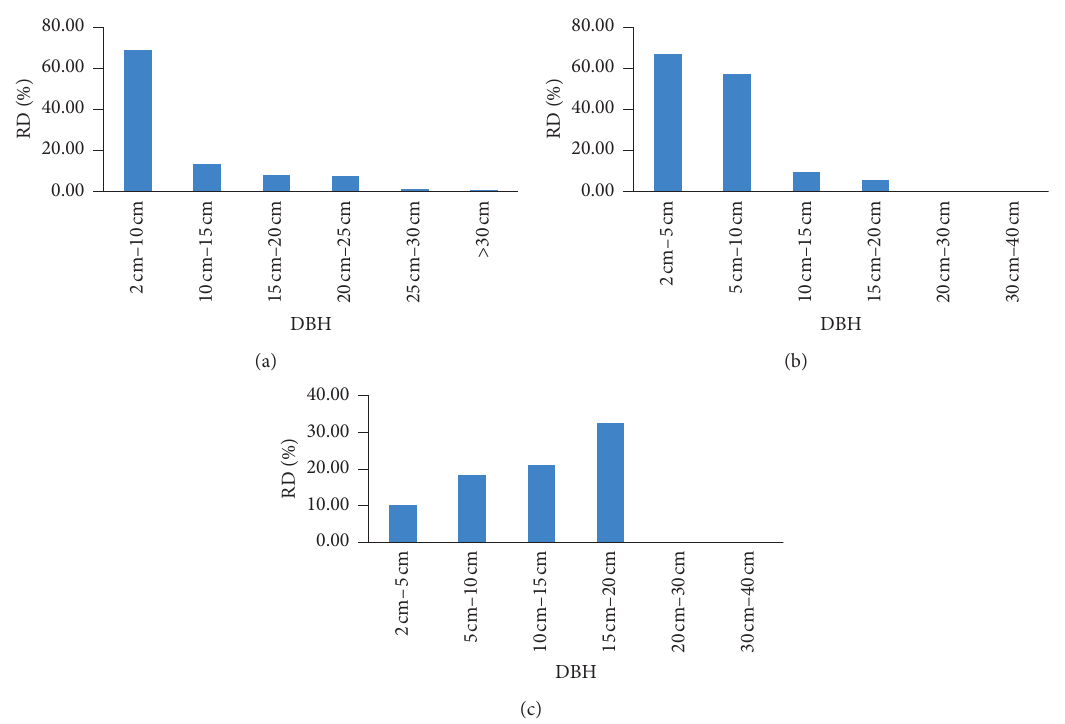
Figure 5: DBH class distribution of some important woody species in free grazed woodland. 0 � < 2cm; 1 � 2–5cm; 2 � 5–10cm; 3 � 10–15 cm; 4 � 15–20cm; 5 � 20–25cm; 6 � 25–30cm; 7 � > 30cm. (a) Acacia tortilis in free gazed woodland. (b) Dichrostachys cinerea in free grazed woodland. (c) Acacia gerrardii in free grazed woodland.